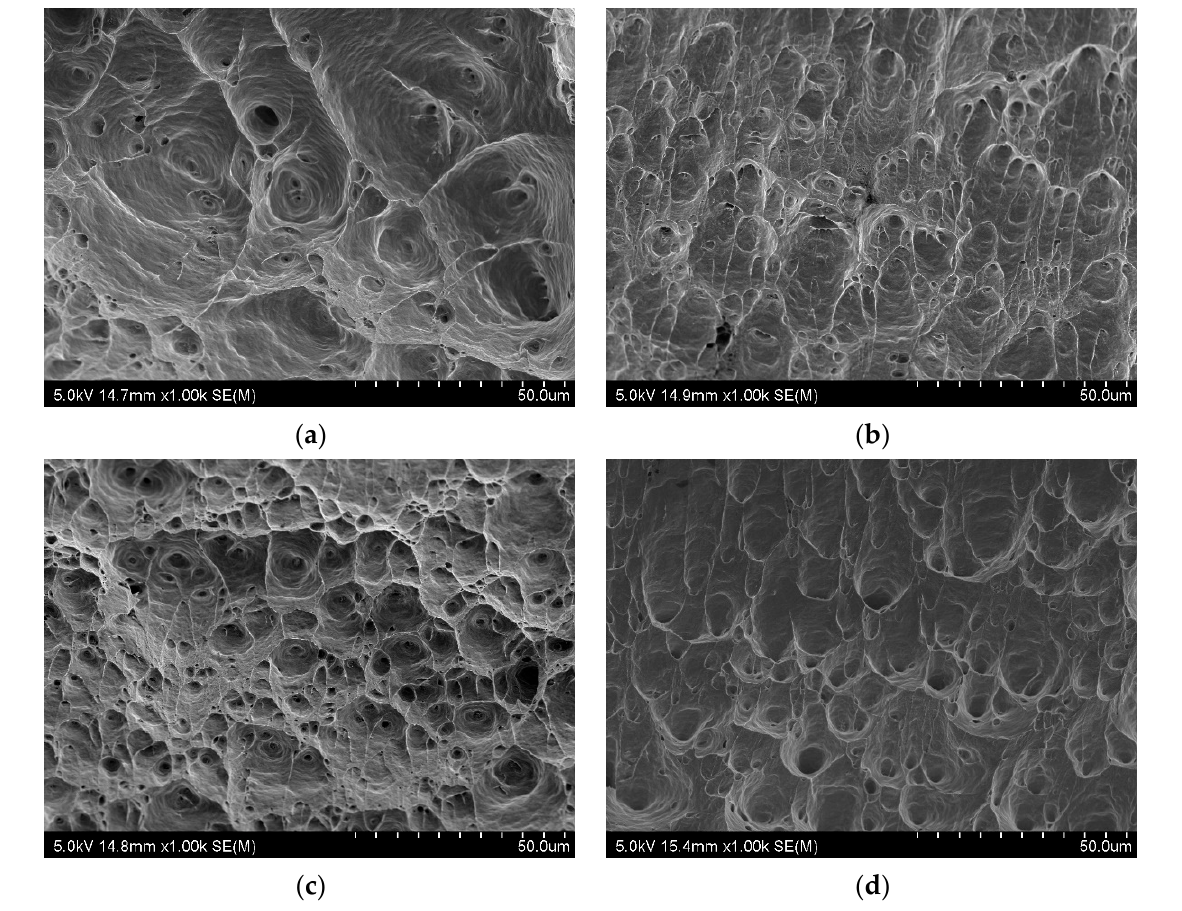
Figure 9. Fractures of the tensile samples cut from the transverse direction: ( a ) CG, ( b ) HE, ( c ) HT1 and ( d ) HT2.